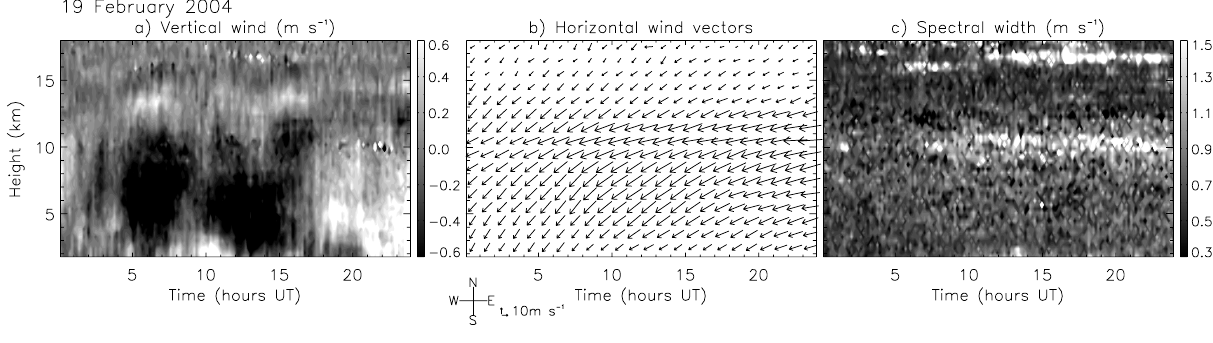
Fig. 7. Height-time plots of (a) vertical wind, (b) horizontal wind vectors, (c) vertical-beam spectral width measured by VHF radar on 19 February